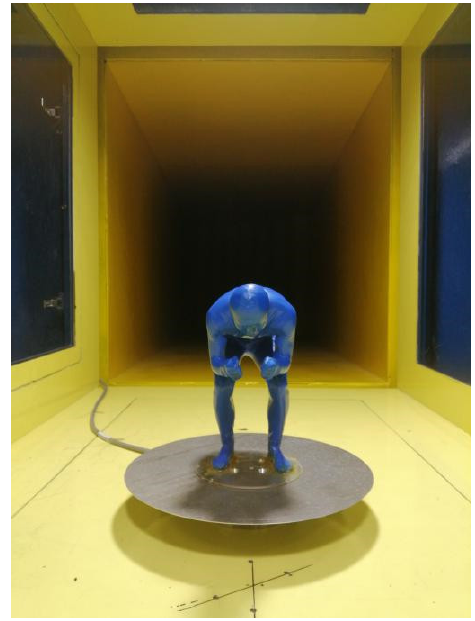
Figure 7. Scale models in the wind tunnel.